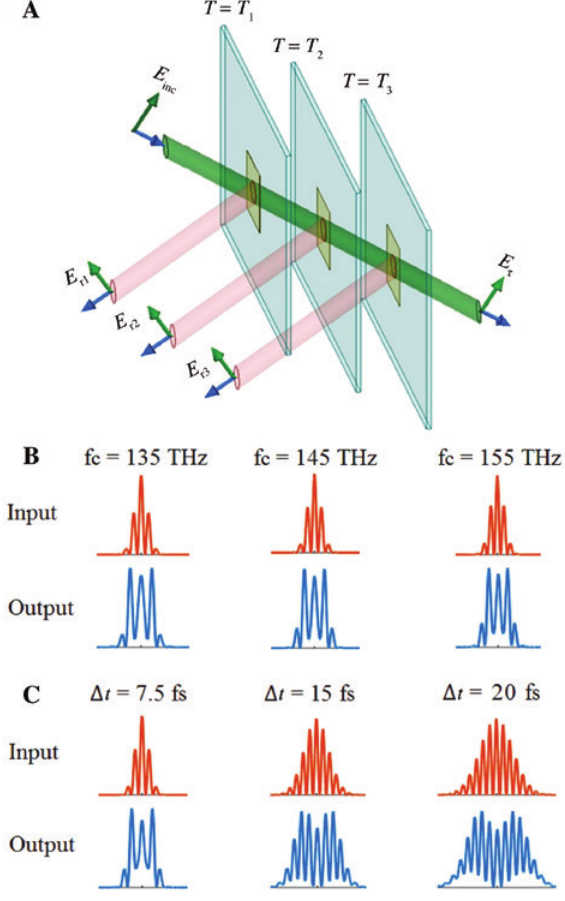
Figure 5: A trilayer metasurface can facilitate a fully temperature controlled pulse shaper for a range of pulses. (A) Multilayer parallel metasurafaces with independent thermal con- trols, in which the oblique incident angle and appropriate distance between the metasurfaces avoid multi-reflections to the output. Pulse shape preservation for variable carrier frequency (B) and vari- able pulse span (C) using the configuration shown in